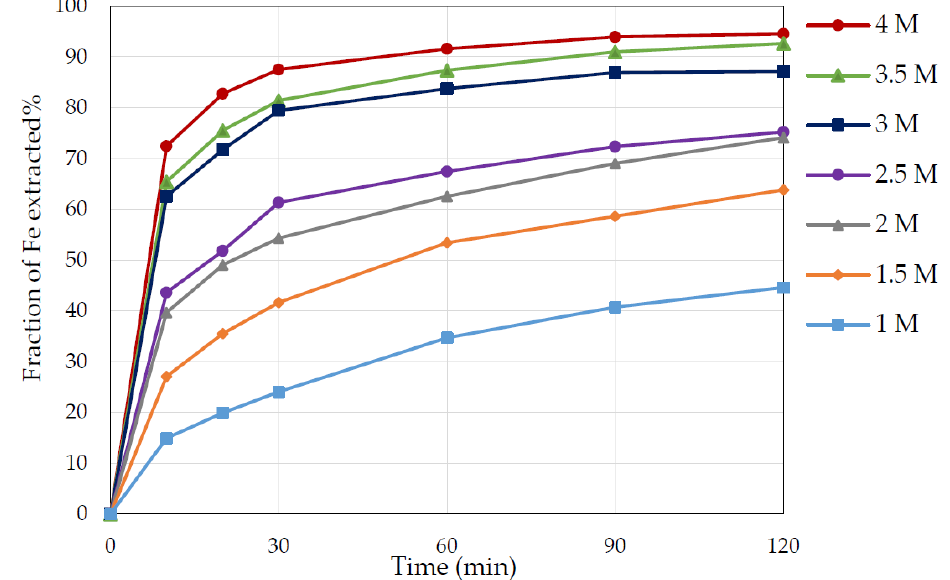
Figure 6. Time dependence of iron extraction from pyrite with different nitric acid concentrations (1 – 4 M). Conditions: temperature 65 °C, S/L ratio 1 to 20, particle size +75 – 106 µm.